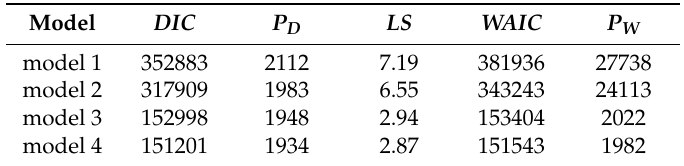
Table 1. Evaluation results of the alternative spatiotemporal Bayesian models for the hand, foot, and mouth disease (HFMD) case of China.